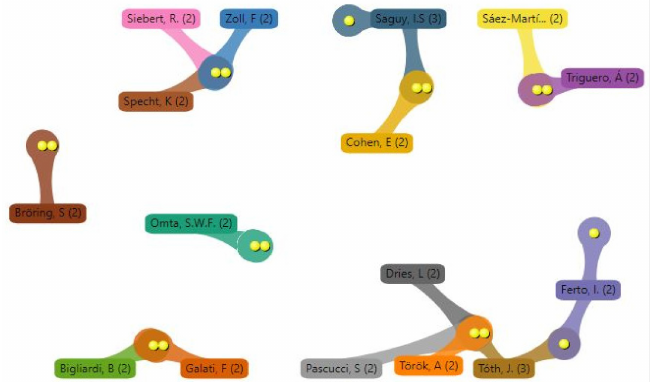
Figure 5. Collaboration clusters among the top 16 main